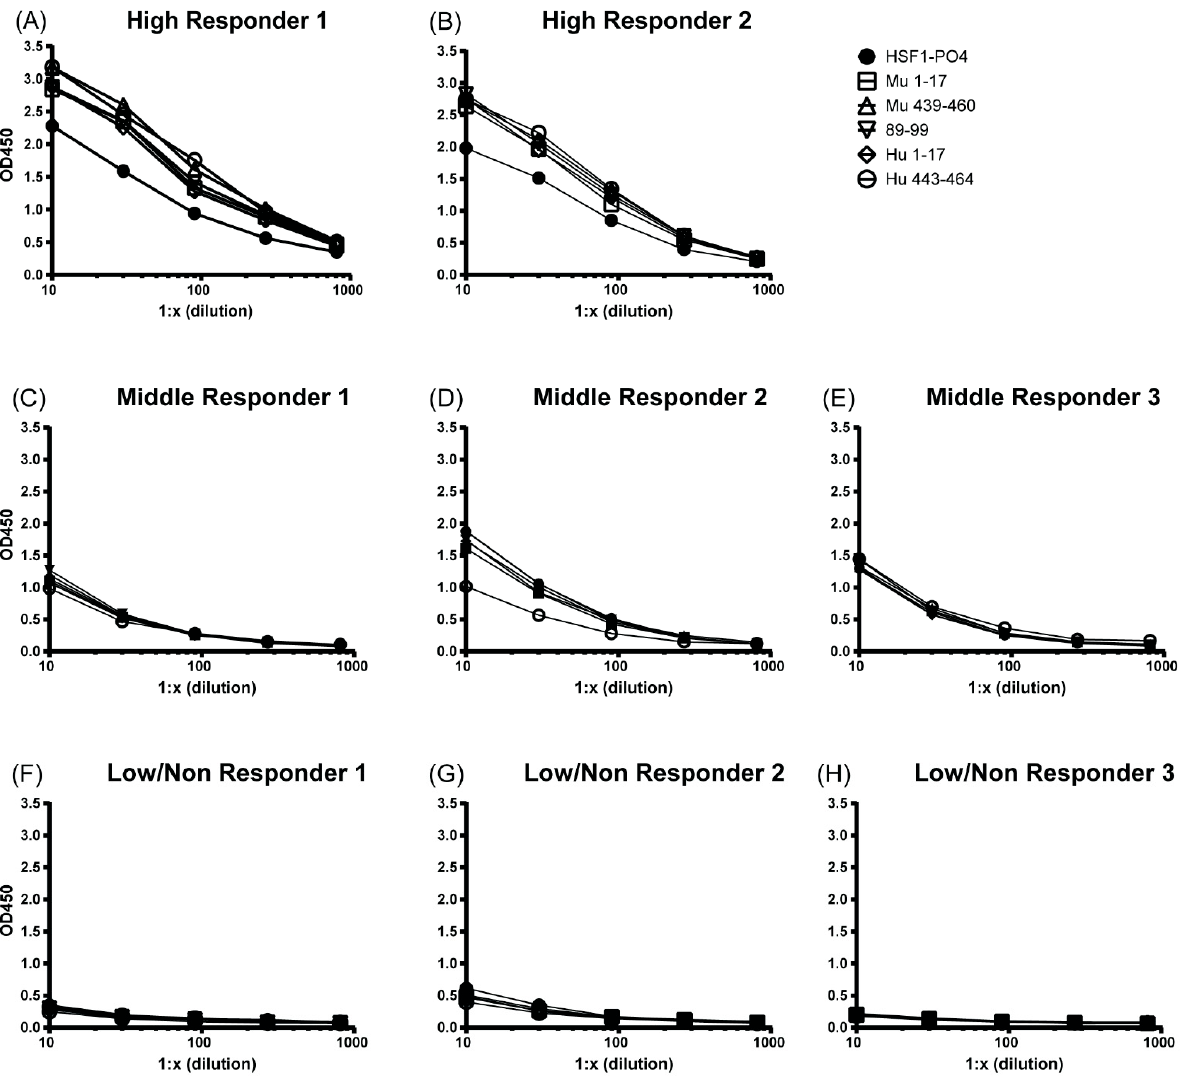
Figure 5. Sensitivity of IgA antibodies to HSF1-PO4 and individual epitopes, at multiple sample dilutions, measured via indirect ELISA. Three-fold serial dilution, of serum, from 1:10 (1:30, 1:90, 1:270 and 1:810), run in duplicate, of individual samples from two high ( A , B ), three mid ( C – E ) and three low ( G – H ) responders to HSF1-PO4. Key is representative of all figures ( A – H ). All open symbols represent peptides and filled in circle represents